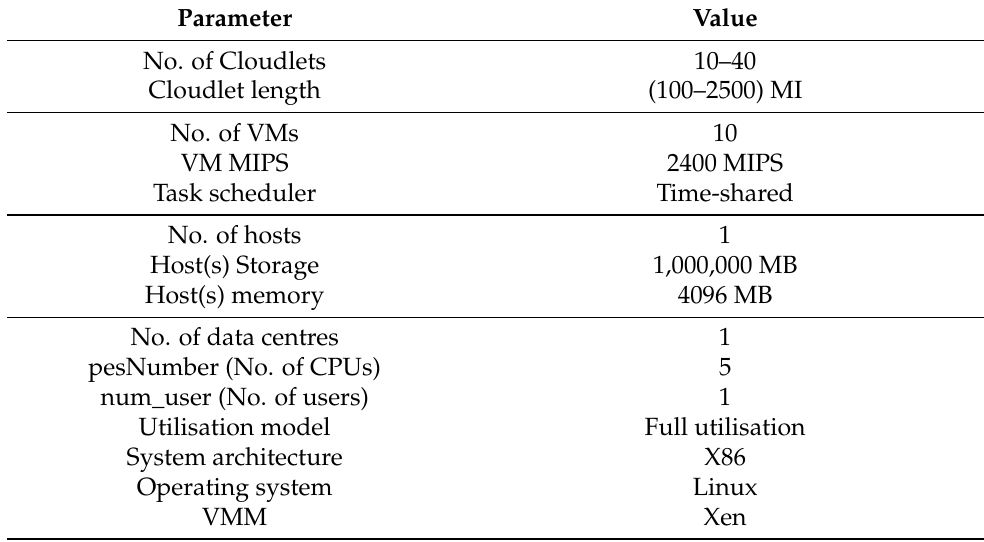
Table 3. Simulation